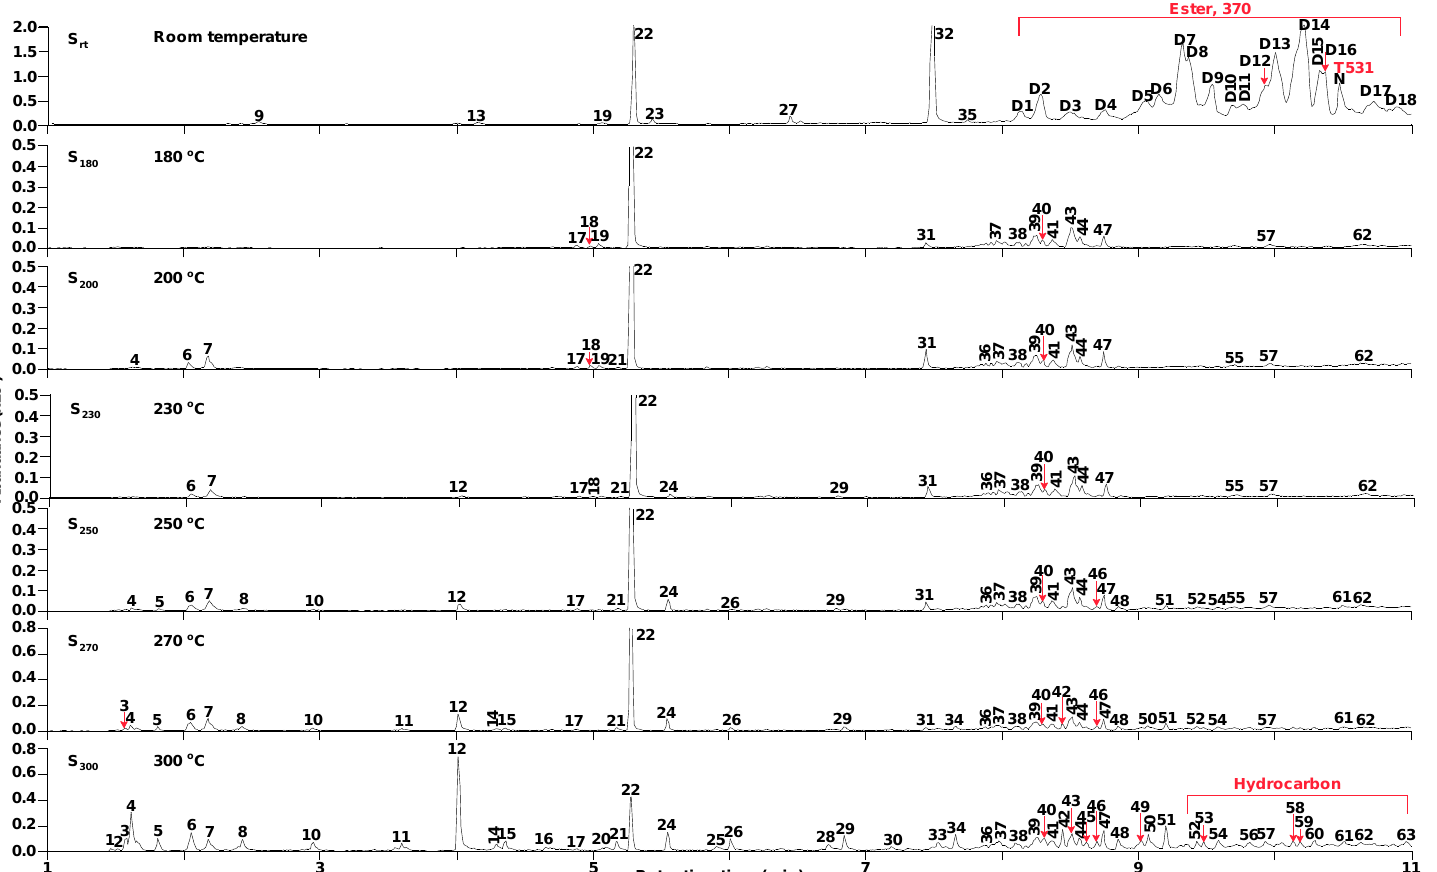
Figure 5. TICs of the oil samples as a function of temperature at retention times of 1 – 11 min.